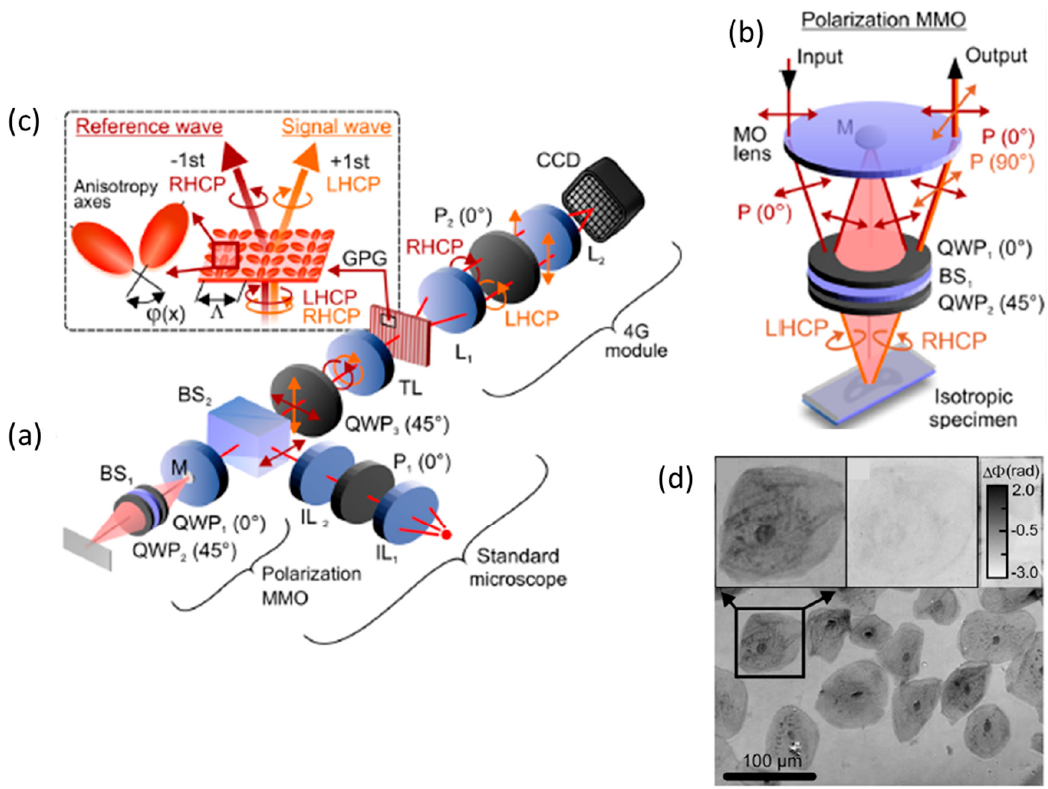
Figure 9. Illustration of quantitative fourth-generation optics microscopy (Q4GOM). ( a ) Experimental setup using 4G optics module connected to microscope with a polarization adapted interference objective. P 1 : input polarizer; IL 1 , IL 2 : illumination lenses; MMO: Mirau microscope objective; BS 1 : pellicle beam splitter; QWP 1 , QWP 2 , QWP 3 : quarter-wave plates; M: reference mirror; BS 2 : beam splitter cube; TL: tube lens; GPG: geometric-phase grating; L 1 : first Fourier lens; P 2 : analyzer; L 2 : second Fourier lens; CCD: charged coupled device. ( b ) Polarization-adapted Mirau microscope objective (MMO) used for imaging of isotropic samples. ( c ) Polarization sensitive transformation of light by geometric phase grating. ( d ) The quantitative phase retardance imaging of human cheek cells. At the top a comparison of the quantitative phase imaging (left) and bright field image (right) of the marked area (adapted from Bouchal et al. [76]).